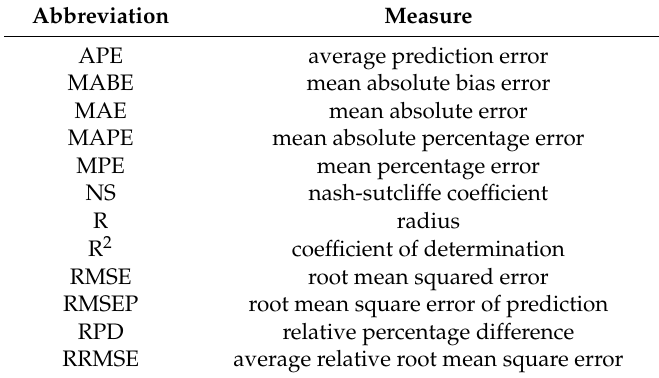
Table 3. Abbreviations for statistical measures for the validation of machine learning algorithms.